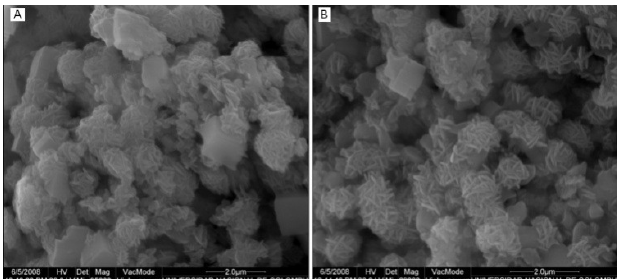
Figure 8. Scanning electron microscopy of the obtained sieve A) Zoom of 25000X, B) Zoom of 29000X.